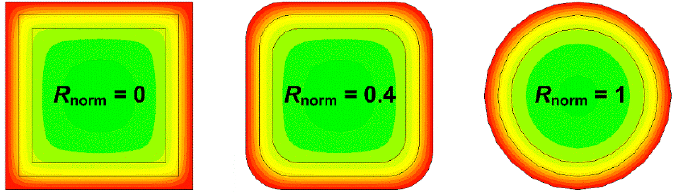
6 of 11 Figure 7. Energy band diagrams of the gate-normal NWTFETs extracted at the ( a ) corner and ( b ) side. 3.2. Hump Suppression by Rounding NW Corners and Reducing Gate Insulator Thickness In order to improve the SS and I on of the gate-normal NWTFETs, the hump behavior must be suppressed. In this paragraph the radius of curvature ( R ) of an NW and T ins are optimized for the suppression of the hump behavior. The normalized R ( R norm ) is defined as 2 R / W inner . The three R norm values are discussed as shown in Figure 8: 0, 0.4, and 1. Figure 9 shows the simulated transfer curves